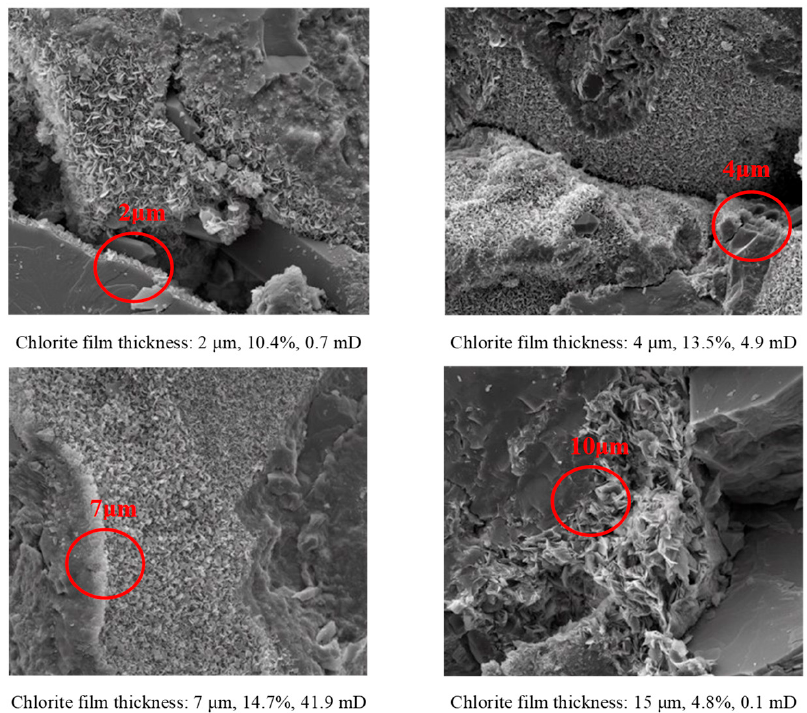
Figure 8. Control of chlorite thickness and inclusion degree on petrophysical